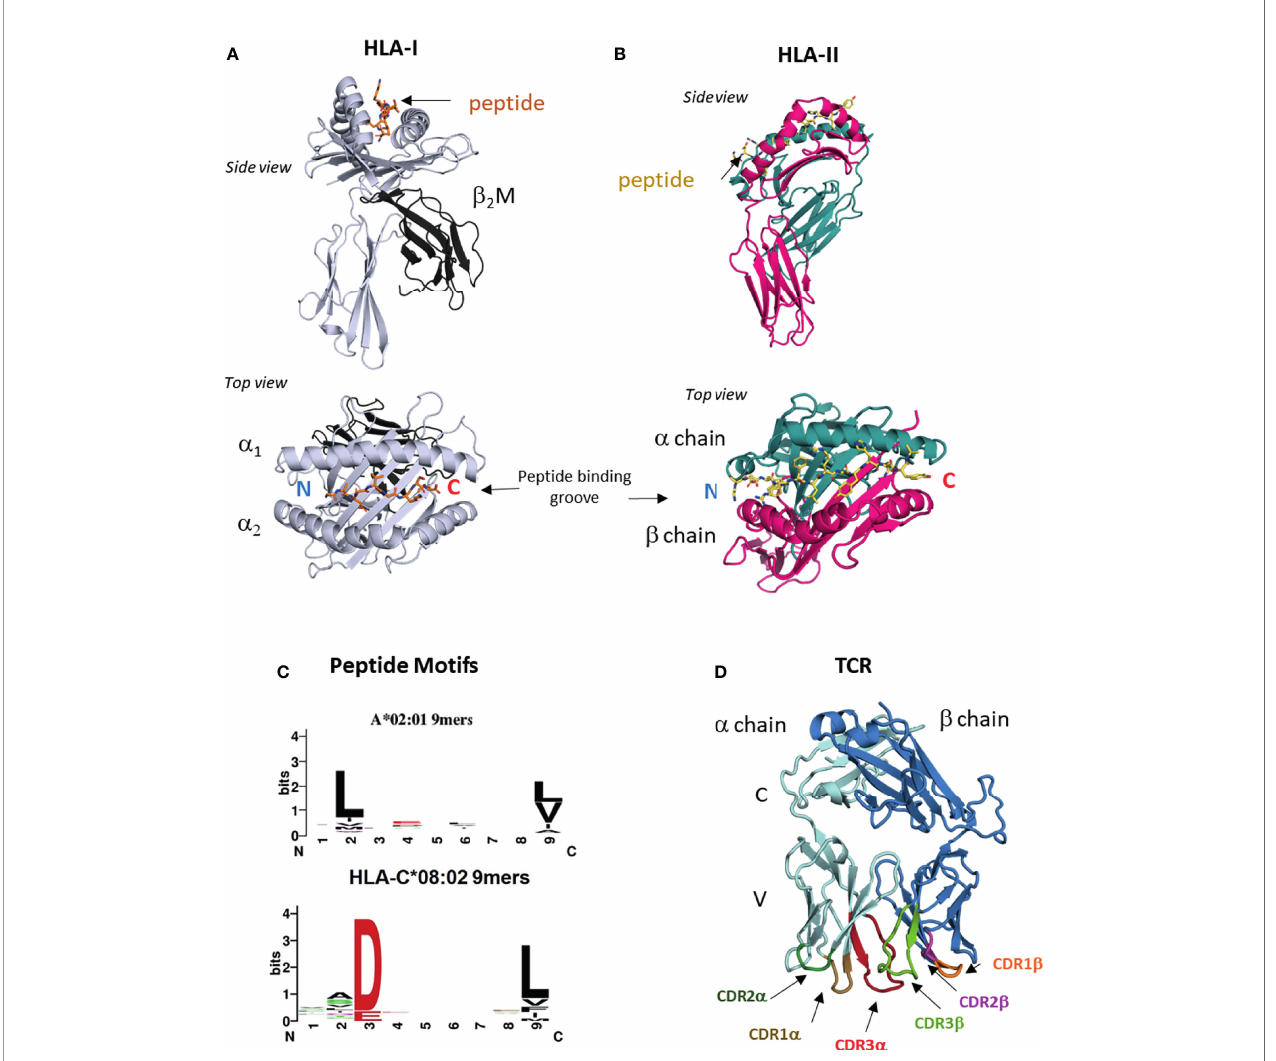
FIGURE 1 | HLA-I, HLA-II and TCRs. (A) Structure of HLA I molecule. Contains HLA-I heavy chain, b 2 M and bound peptide. Peptide binding groove consists of a 1 and a 2 domains of HLA-I heavy chain (PDB entry 6ULI). (B) Structure of HLA-II molecule. Contains HLA-II alpha and beta chains and bound peptide. Peptide binding groove is shared by alpha and beta domains (PDB entry 1AQD). (C) Examples of peptide motifs for 9mer peptides eluted from two different HLA-I molecules, HLA- A*02:01 and HLA-C*08:02. Single letter amnio acid code is used. Size of letter indicates prominence of that residue. Anchor residues are de fi ned by restricted amino acid usage, commonly at p2, p3 and p9. (D) Structure of ab TCR showing constant (C) and variable (V) regions and six CDR loops (PDB entry